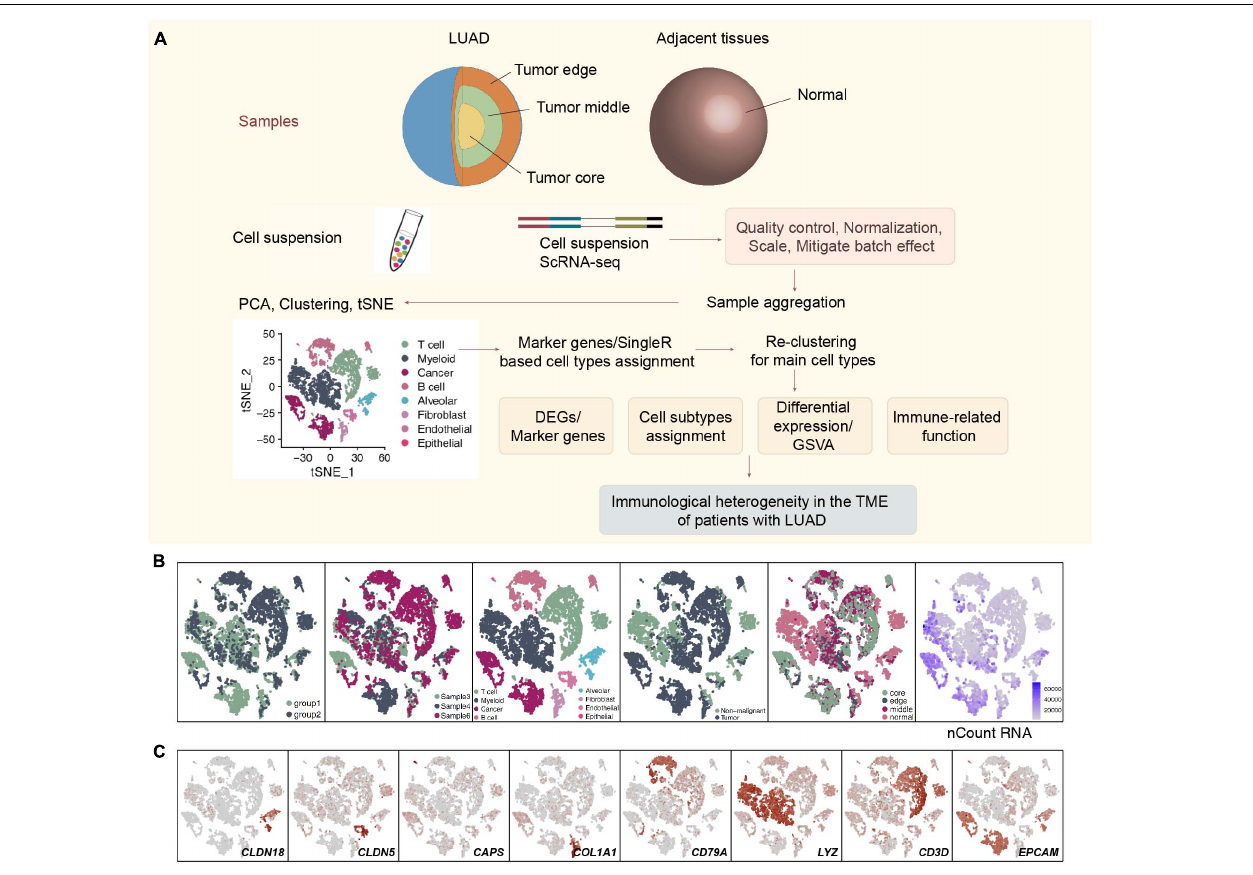
FIGURE 1 | Overview of 9,993 single cells from LUAD and adjacent non-malignant LUAD. (A) Overview of the scRNA-seq analysis in this study. (B) tSNE of the 9,993 cells profiled, with each cell color-coded for (left to right) its batch group (batch 1 and batch 2), the corresponding patient, the associated cell type and the sample origin (tumor or non-malignant tissue), and the number of transcripts (UMIs) detected in that cell (log scale is defined in the inset). (C) Expression of marker genes for the cell types defined above each